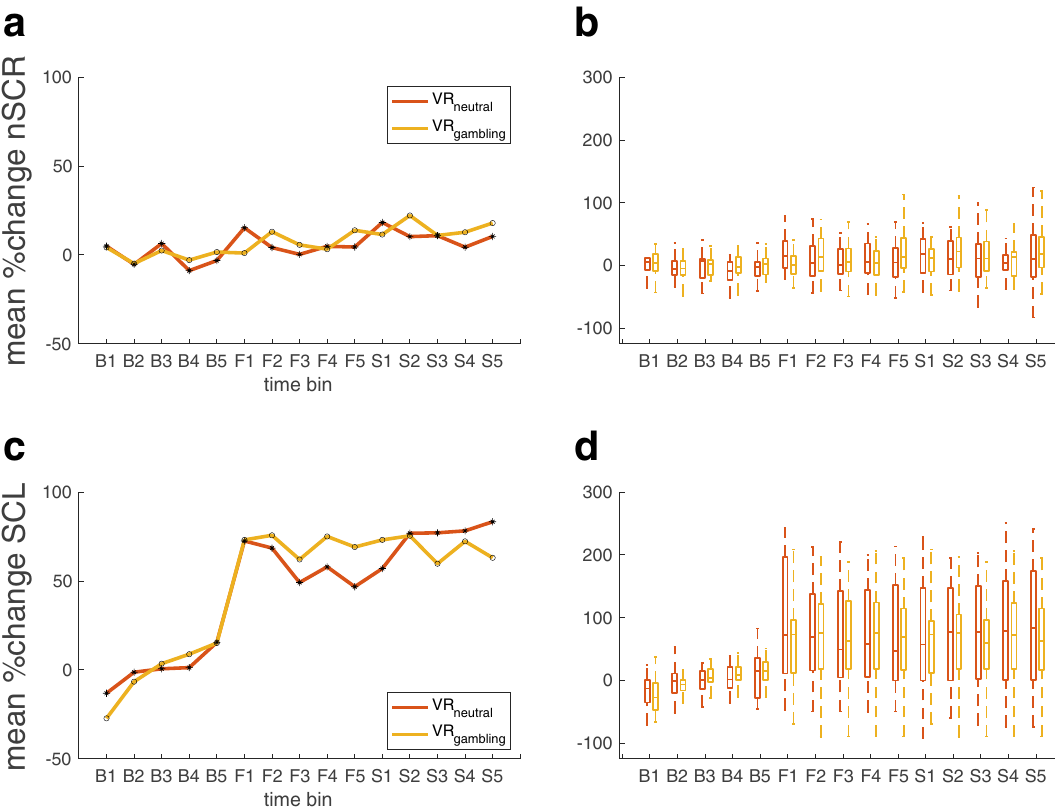
Figure 6. Results of the EDA measurements divided into 15 time points over the course of the baseline phase, measured before participants entered the VR-environments, and the first and second exploration phases. Each of the three phases is divided into five one-minute bins (B1-5: pre-VR baseline, F1-5: first exploration phase in VR, S1-5: second exploration phase VR). ( a ) Median percent change from baseline mean for no. of spontaneous SCRs over all participants. ( b ) Boxplot of percentage change from baseline mean for no. spontaneous SCRs over all participants. ( c ) Median percent change from baseline mean of SCL over all participants. ( d ) Boxplots of percentage change from base line mean of SCL over all